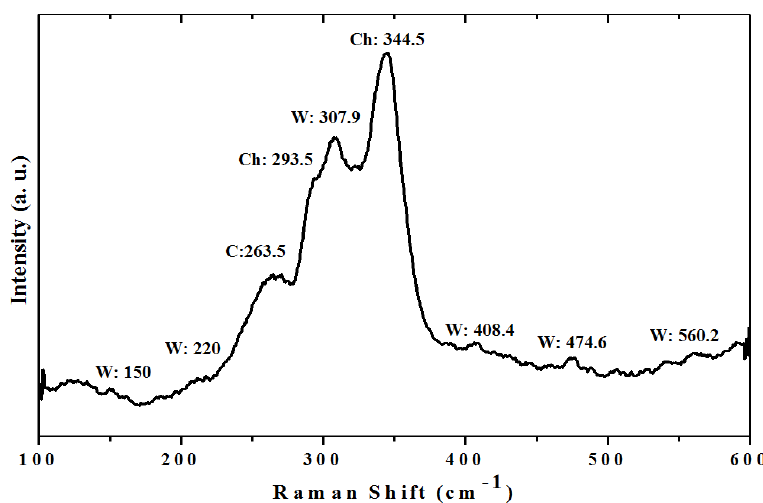
Fig. 2. Raman spectrium of CFS-9 (sample 9) synthesized by thermolysis